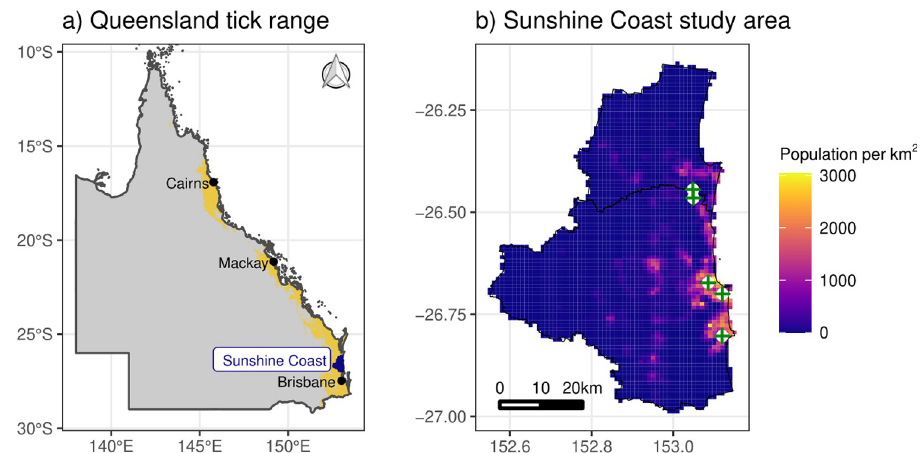
Fig 1. Location of the study area. a) Location of the Sunshine Coast study area (blue coloured polygon) within the approximate distribution of the paralysis tick Ixodes holocyclus in Queensland, Australia (yellow coloured region). The approximate distribution is the output of a species distribution model trained on open access occurrence records (Atlas of Living Australia, Global Biodiversity Information Facility) and is used here for illustrative purposes only. b) Locations of participating veterinary clinics (cross symbols) within the Sunshine Coast. Colours represent human population density as of 2018. The Queensland state polygon was accessed from the Australian Bureau of Statistics at https://www.abs.gov.au/statistics/standards/australian-statistical-geography-standard-asgs-edition-3/jul2021-jun2026/ access-and-downloads/digital-boundary-files/STE_2021_AUST_SHP_GDA2020.zip. https://doi.org/10.1371/journal.pcbi.1009874.g001 temporal periods (periodicity = 24). We used seasonal-trend decomposition based on Loess smoothing (STL; [26]) to decompose the series into seasonal, trend and remainder compo- nents (Fig 2). In an STL decomposition, the seasonal component is calculated by applying